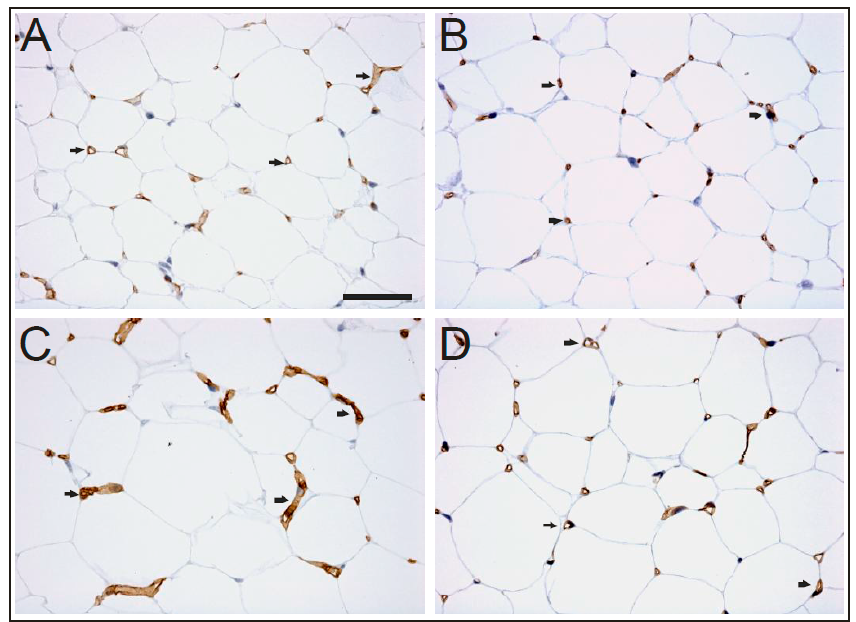
Figure 1. AQP1 expression in capillary endothelia of mouse WAT. Immunohistochemical staining of AQP1 in paraffin-embedded sections of the WAT from control and fasted mice (control: AQP7 − / − ( A ); AQP7+/+ ( B ); fasted: AQP7 − / − ( C ); AQP7+/+ ( D )). Anti-AQP1 antibody labels small capillaries of WAT in control ( A , B ) and fasted ( C , D ) mice. Arrows indicate localization of AQP1 in mouse WAT. A bar indicates 50 µm.